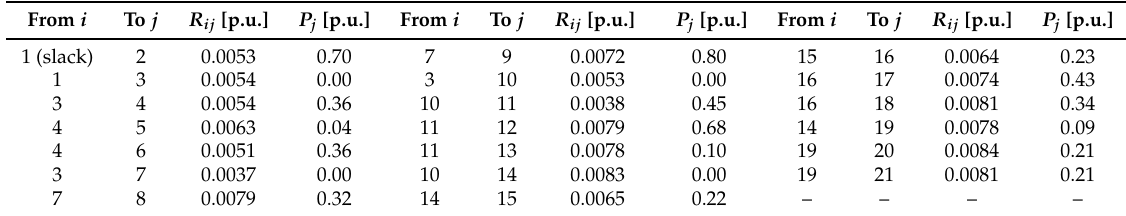
Table 2. Parameters for the 21-node test